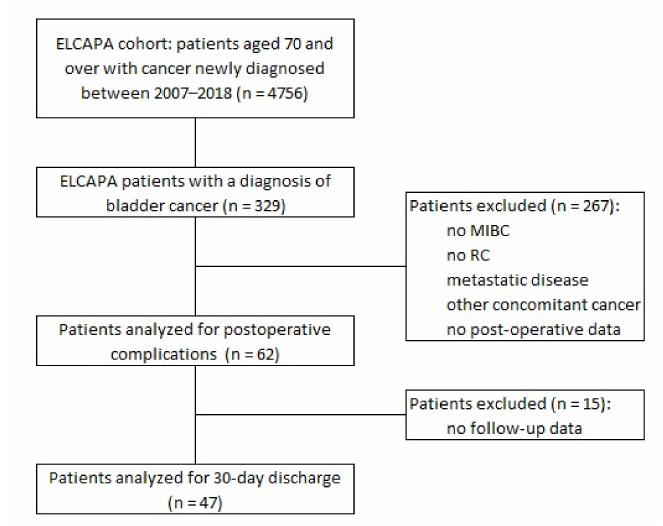
Figure 1. Flow diagram of participants. MIBC: muscle-invasive bladder cancer; RC: radical